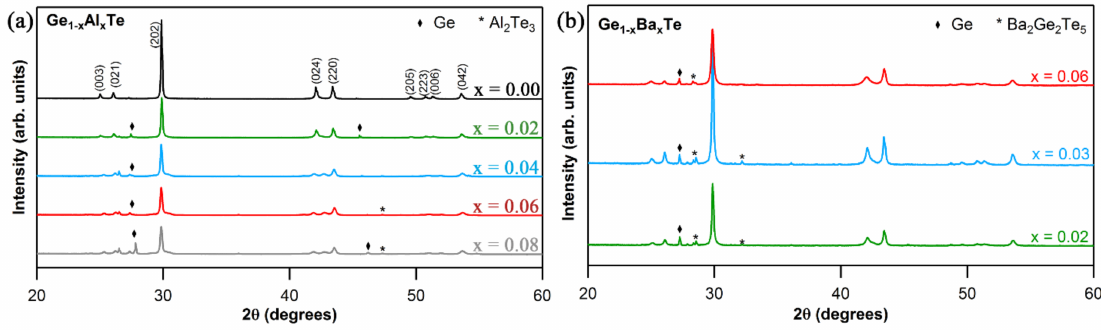
Figure 1. XRD patterns for Ge 1 − x Al x Te ( a ) and Ge 1 − x Ba x Te ( b ) systems.